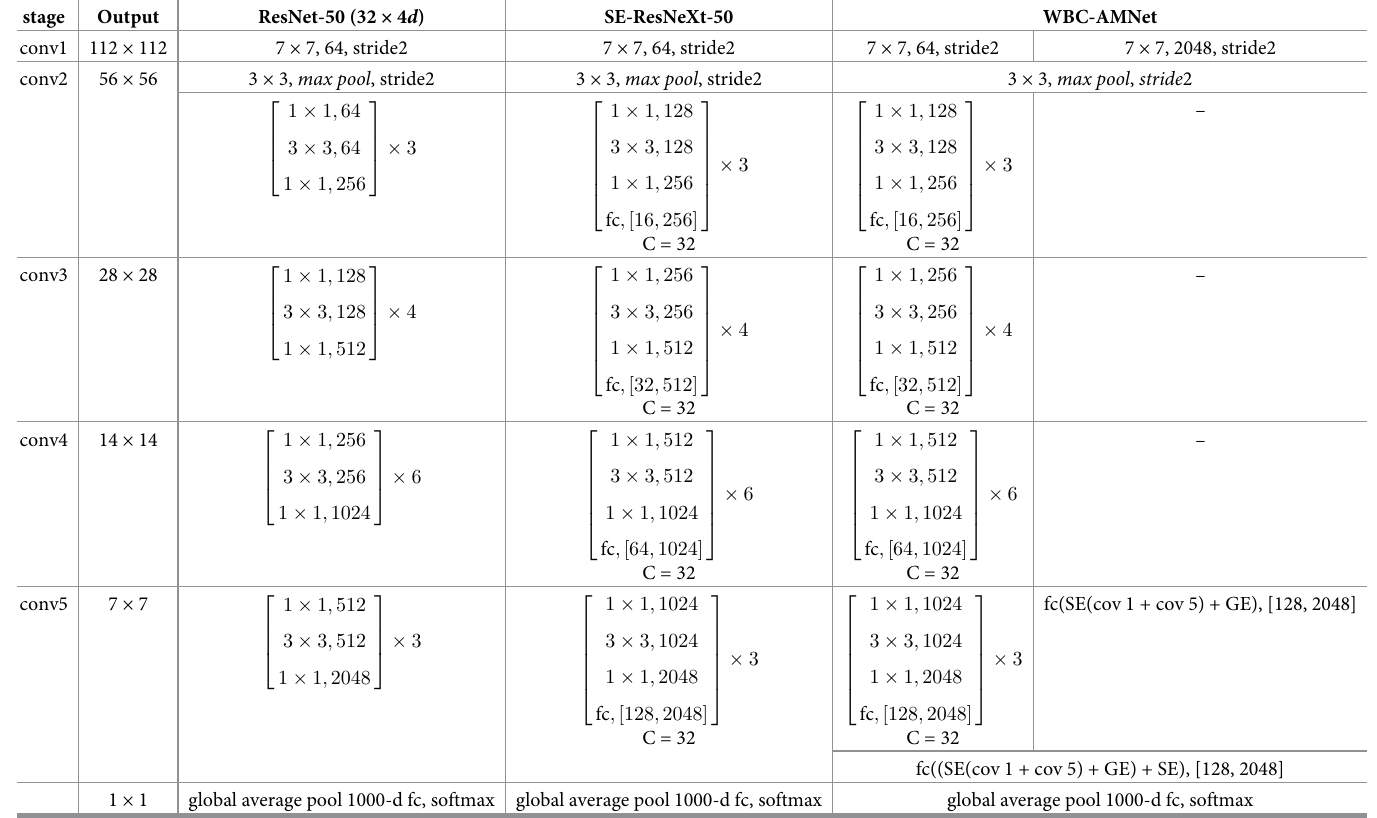
Table 2. Comparison of CNN structure between WBC-AMNet and other models. stage